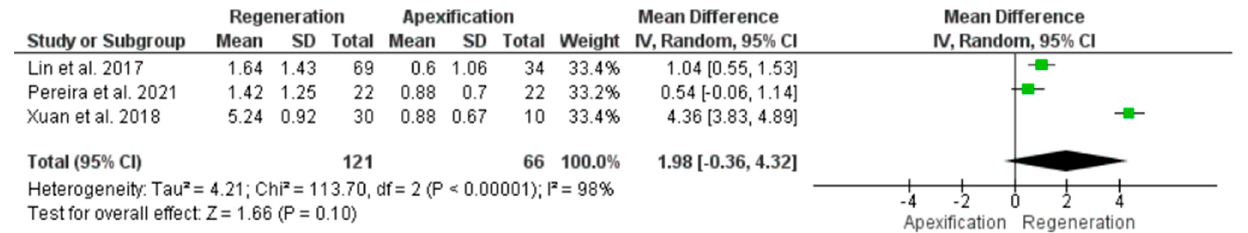
Figure 13. Meta-analysis of increase in root length (IRL) in young immature teeth treated with re- generative endodontic procedure (REP) or apexification procedure.